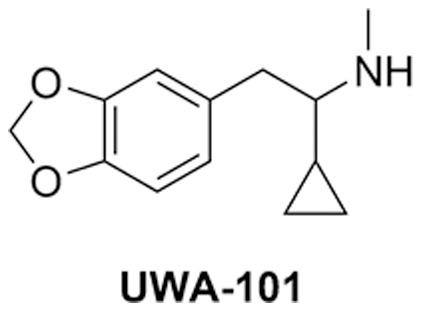
Chemical structure of UWA-101.